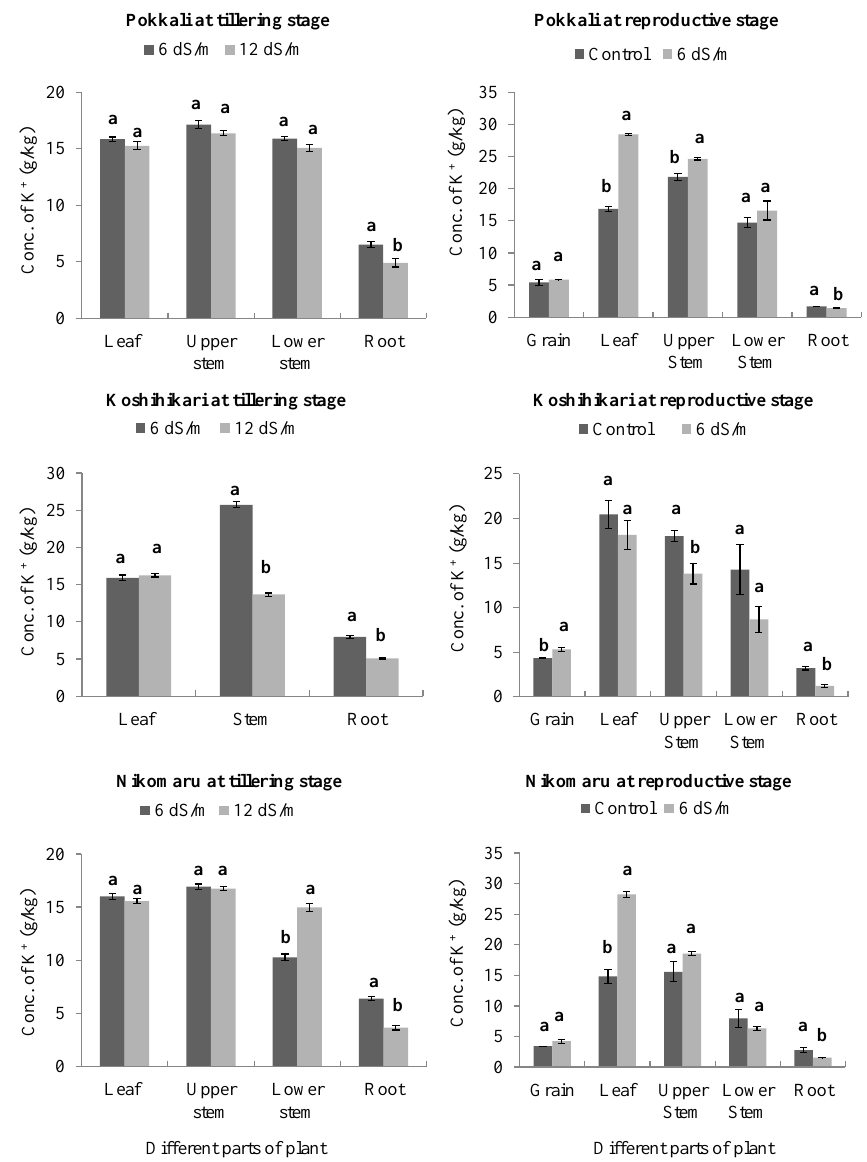
Figure 3. Average concentration of potassium ions in different parts of the rice plant body in the tillering stage (under 6 and 12 dS/m saline irrigation) and in the reproductive stage (under control and 6 dS/m saline irrigation). Error bars represent standard errors ( n = 6). Different letters on bars indicate statistical difference at p ≤